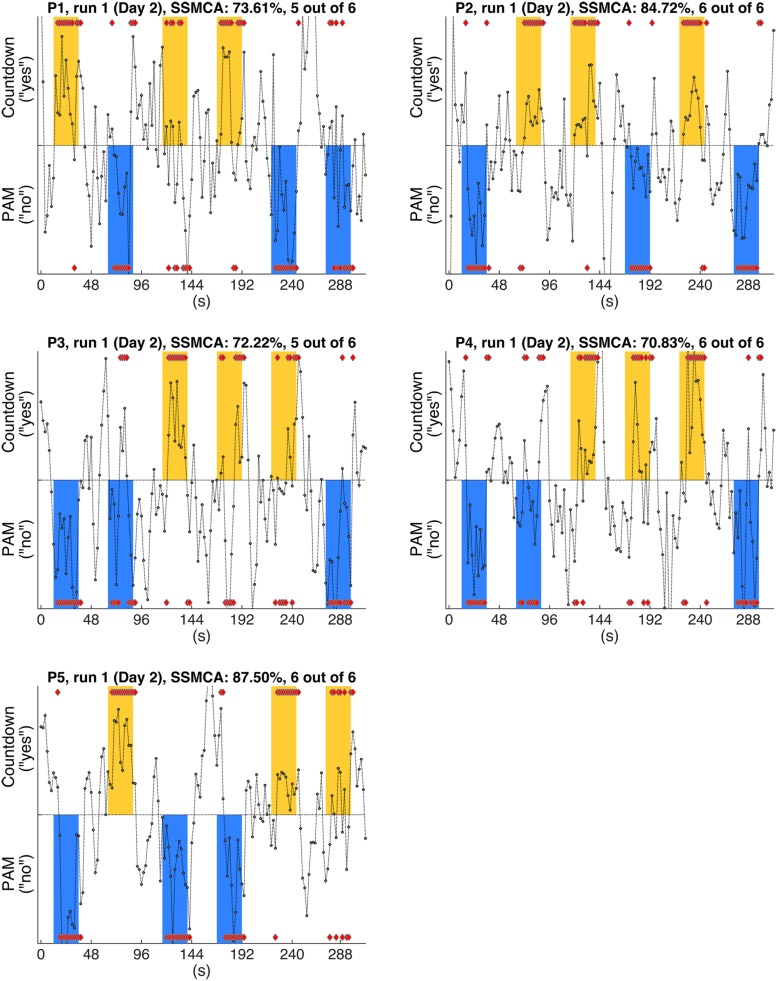
Gray circles show the timecourses of the actual values output by the individual classifiers when discriminating the whole-brain fMRI scans, for each one of the participants (P1-P5). Figures show the results of typical runs (run 1, Day 2). By definition, positive outputs indicate that the classifier judged that the fMRI scan belonged to the positive class (Countdown/yes); likewise, negative outputs indicate that the classifier judged that the fMRI scan belonged to the negative class (PAM/no); red diamonds show the assigned class for the scans in the response periods. The yellow and blue bars show the time intervals when participants were supposed to provide answers (yes/no) to each one of the sentences (S1–S6, Table 1) by performing the corresponding mental task. Furthermore, yellow bars indicate that the factual answer given by that particular participant to the preceding sentence was ‘yes’, whereas blue bars indicate that the factual answer was ‘no’ (answers were collected via questionnaires at debriefing time). Single scan mean classification accuracy (SSMCA) is the percentage of correctly classified response period scans over the entire run. “n out of 6” denotes that n sentences out of 6 were correctly classified in that run, when applying the majority vote to the first 11 scans of each response period.